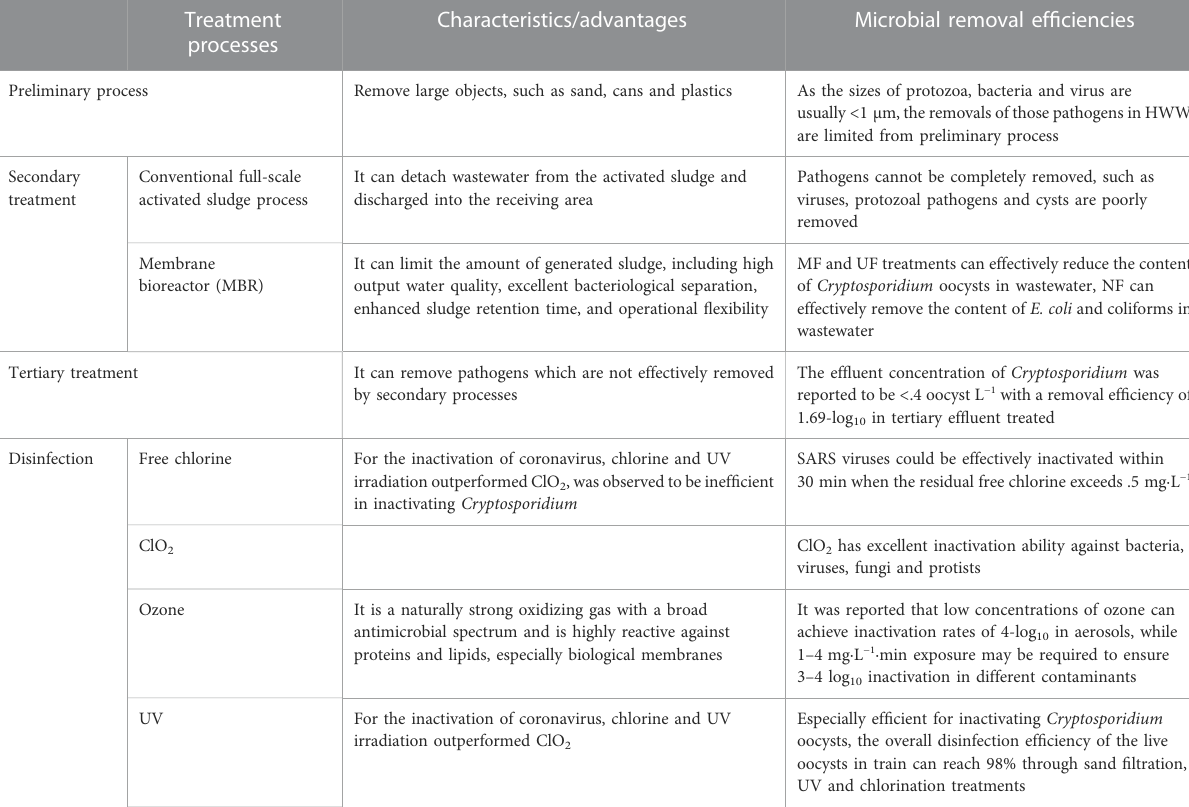
TABLE 2 The removal ef fi ciencies of microorganisms in different treatment